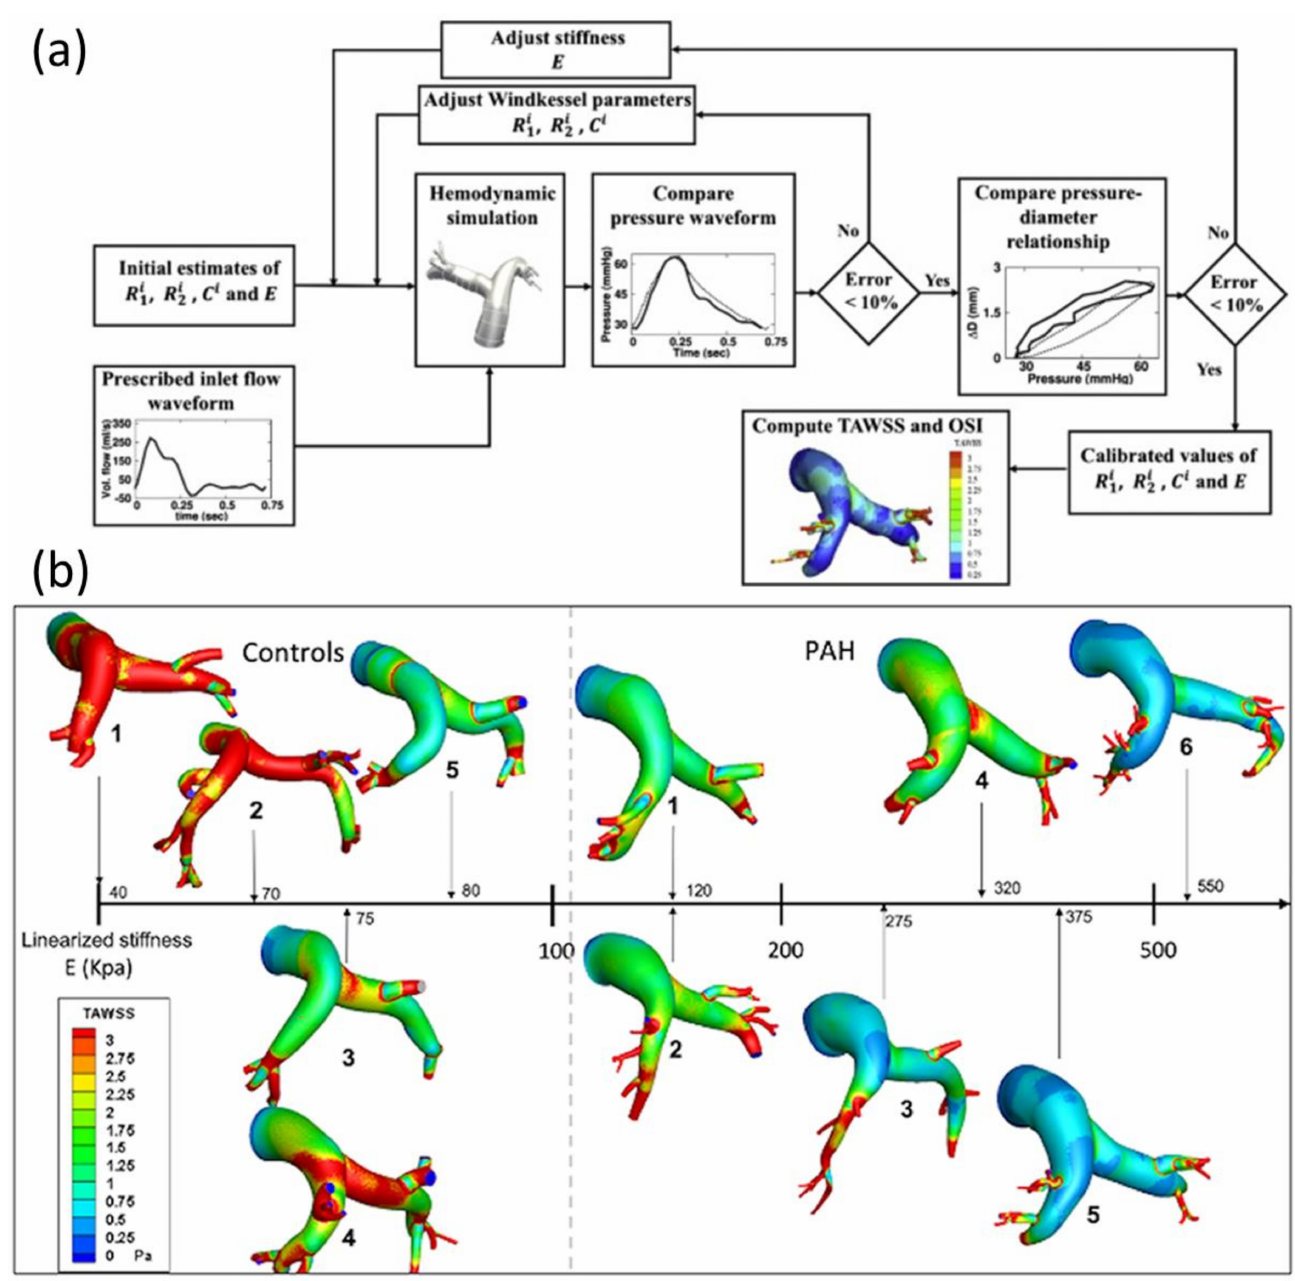
Figure 15. Iterative inverse method and results for the study of pulmonary artery hypertension. ( a ) Double optimization loop for the inverse resolution of distal vasculature Winkesel model parame- ters and wall elastic modulus from phase contrast MRI data. (Reprinted/adapted with permission from Ref. [305]. 2018, Elsevier) ( b ) Biomechanical parameters of pulmonary artery from healthy individuals and pulmonary artery hypertension patients. Models are organized from left to right according to the wall elastic modulus (stiffness) scale, colormaps show the time-averaged wall shear stress (TAWSS) distribution (Reprinted/adapted with permission from Ref. [306]. 2021, Zambrano et al.; open